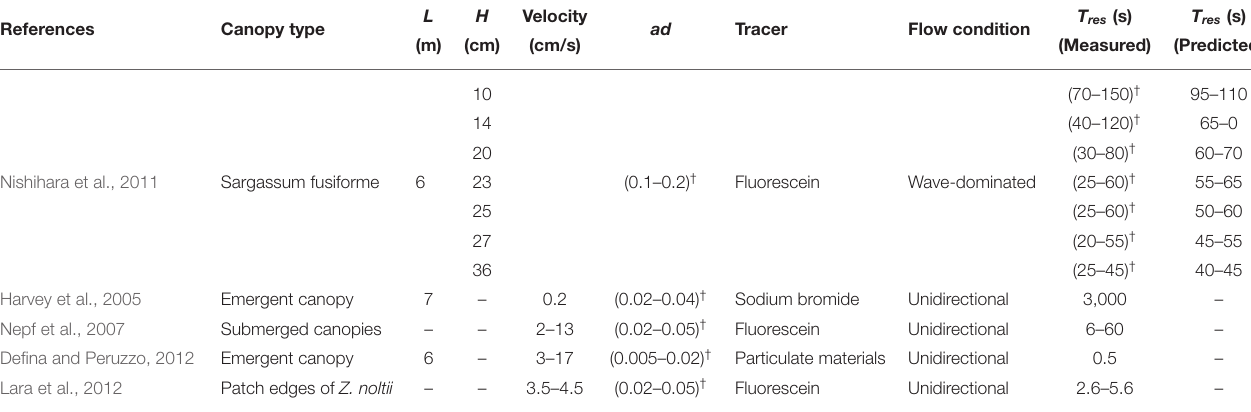
TABLE 2 | Available field measurements of canopy residence time.